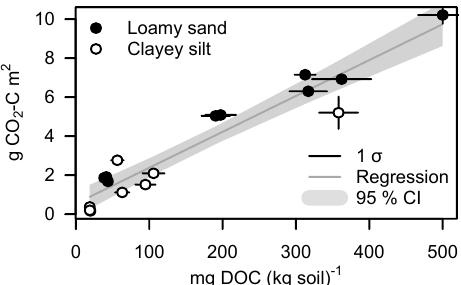
Figure 6. Regression between DOC (mg per 100gsoil) measured after the incubation and the respective cumulated CO 2 emissions (gCm − 2 ) during the period of aerobic headspace with their stan- dard deviations and confidence interval (95%). If error bars are not visible, they are smaller than the symbols of the means. Both soils showed increasing emissions with increasing soil DOC contents as well as a good regression fit ( R 2 = 0.91, p <